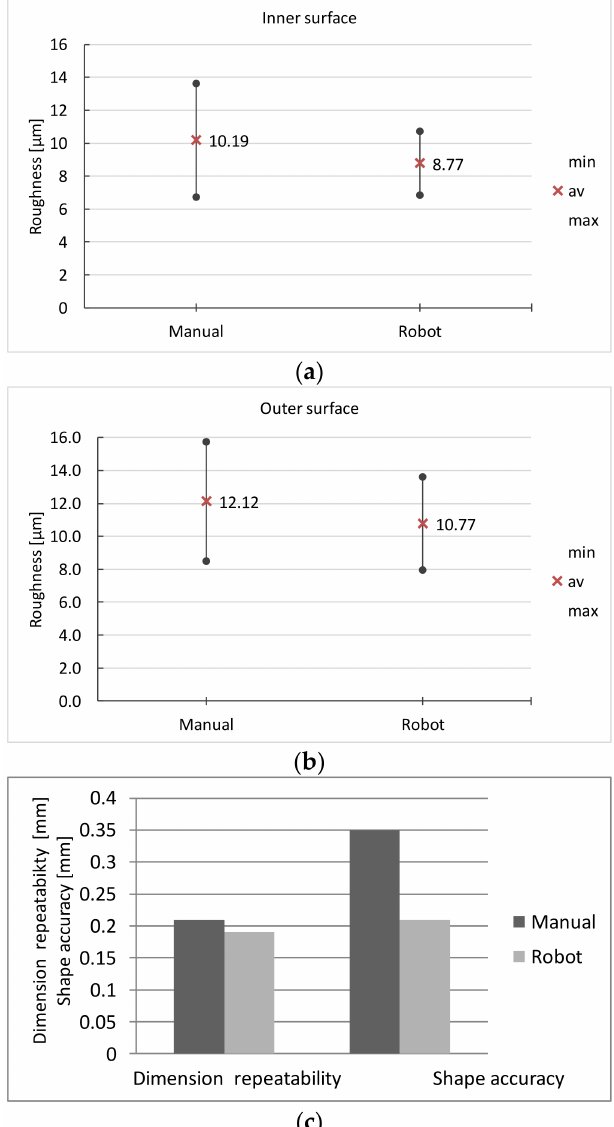
Figure 14. Comparison of: ( a,b ) surface roughness and ( c ) dimensional repeatability and shape accuracy obtained with manual and robot grinding.